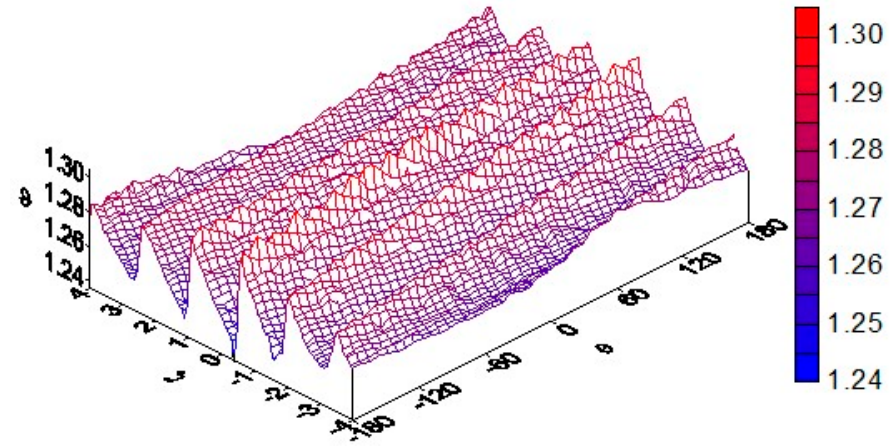
Figure 9. The 3-D axial-angular instantaneous distribution of function ϑ on the surface 0 ≤ | θ | ≤ 180 ◦ , 0 ≤ | ζ | ≤ 4 for ξ = 0.8 and Fo = 0.5.